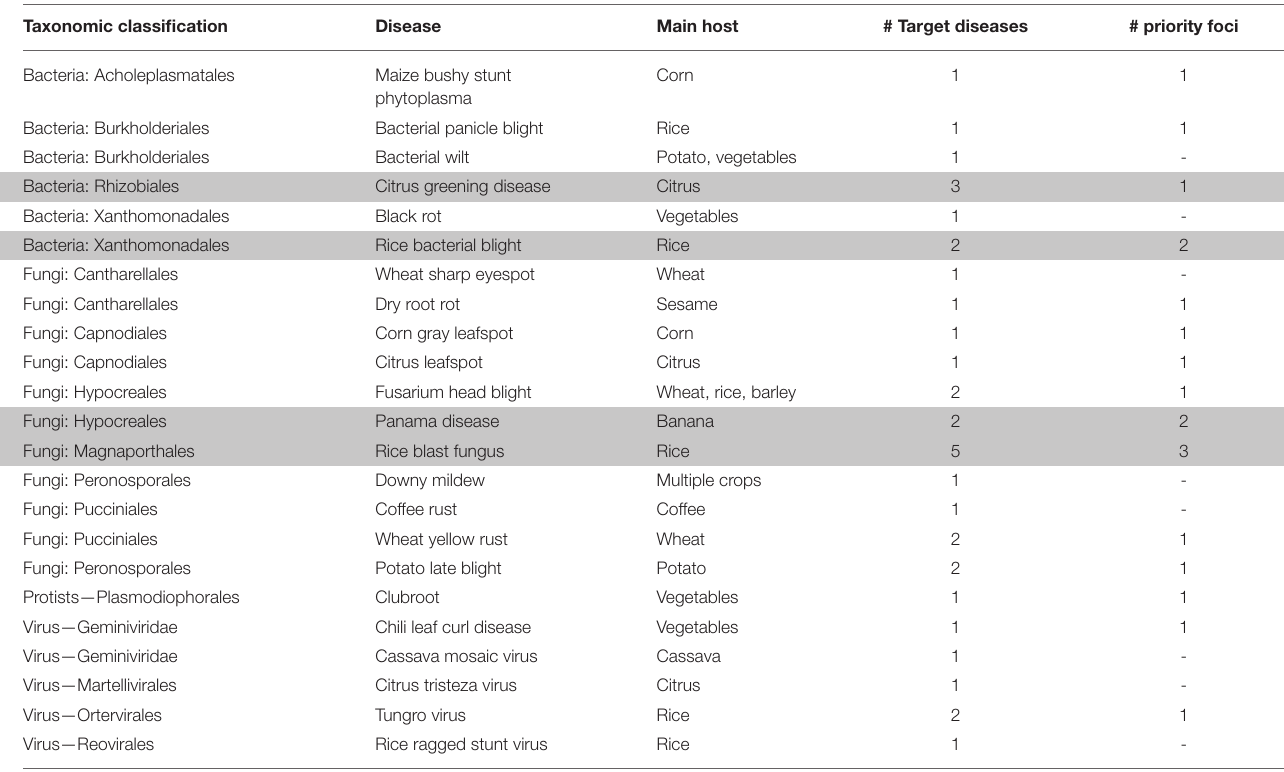
TABLE 1 | Common plant disease targets and priority foci, as enumerated by different Asia-Pacific countries.